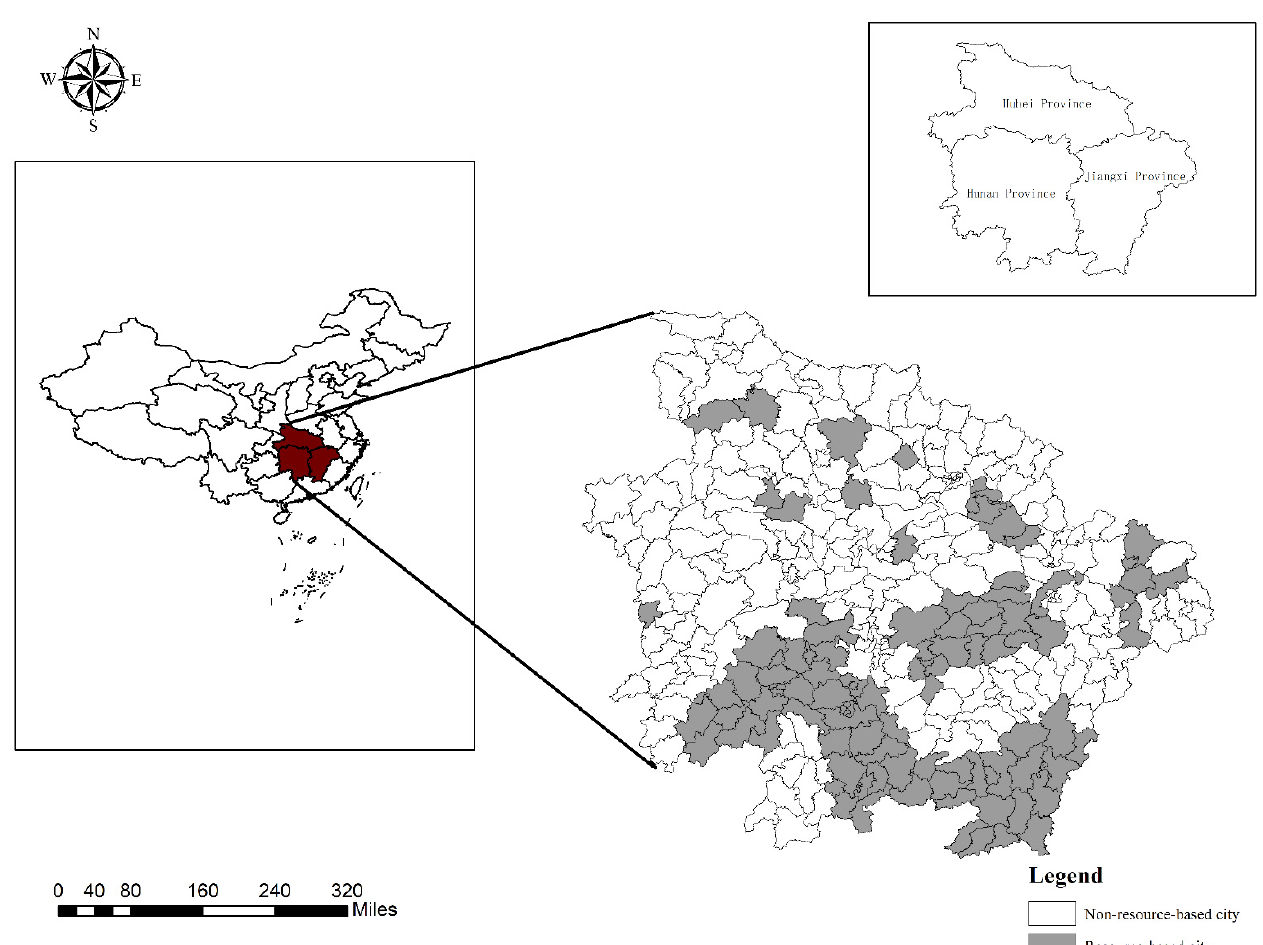
Figure 1. Spatial distribution of urban agglomeration in the middle reaches of the Yangtze River.